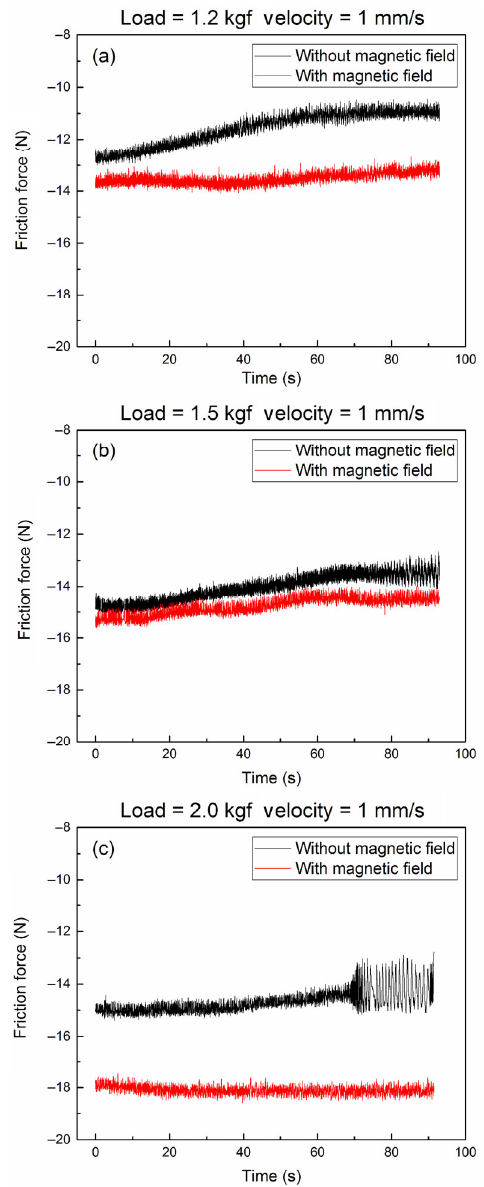
Fig. 5 Results of friction force tests under velocity of 1 mm/s without and with a magnetic field: (a) load of 1.2 kgf, (b) load of 1.5 kgf, (c) load of 2.0 kgf.